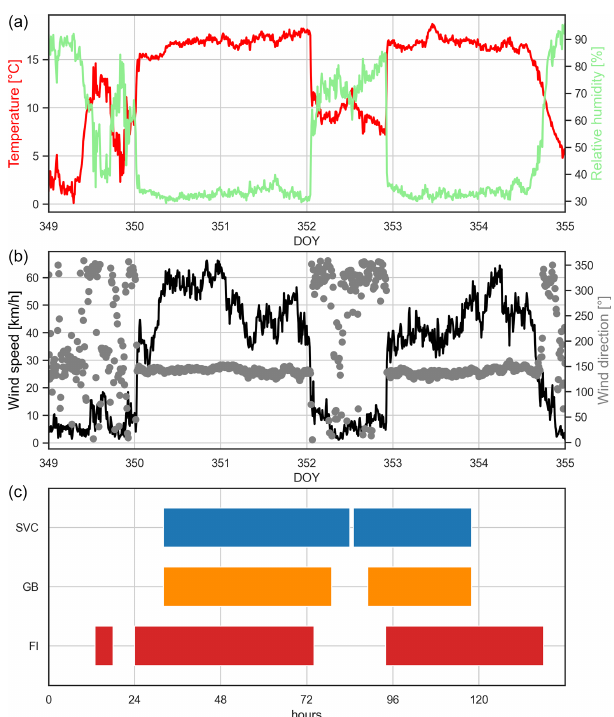
Figure 8. Time series of the six top predictors of the GB algorithm (most important features as shown in Fig. 6) for the analysed time period (15–21 December 2019). Observed foehn events (FI = 1) are colour-coded in